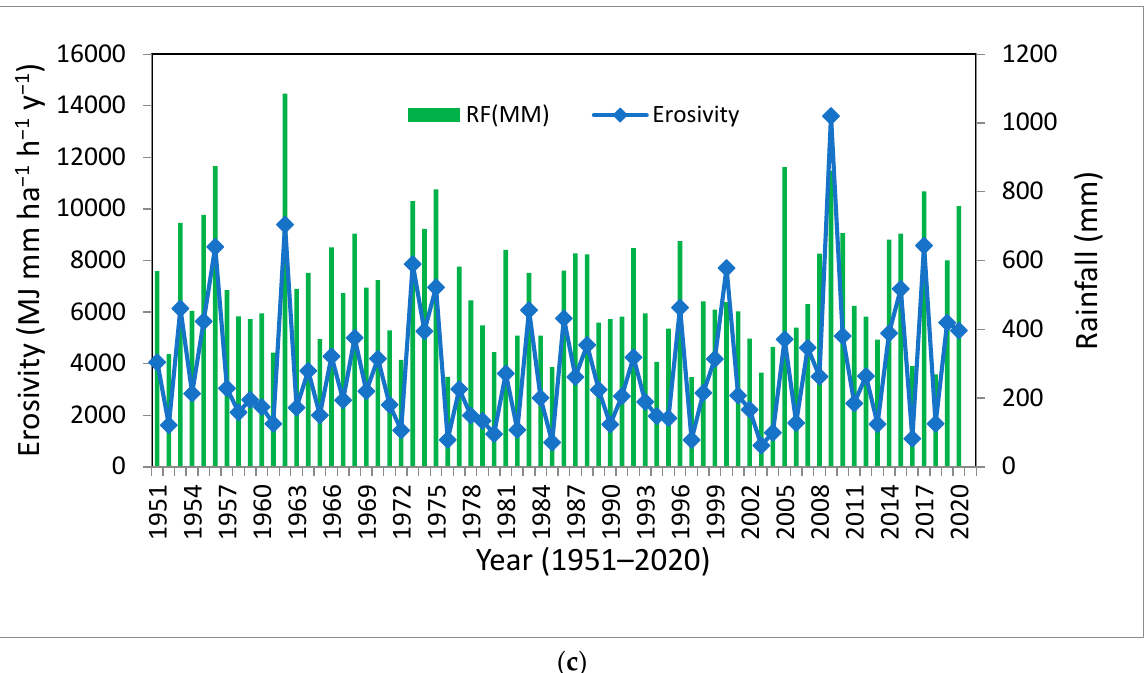
Figure 5. ( a ). Variation in rainfall and erosivity in high-rainfall area. ( b ). Variation in rainfall and erosivity in medium-rainfall area. ( c ). Variation in rainfall and erosivity in low-rainfall area.